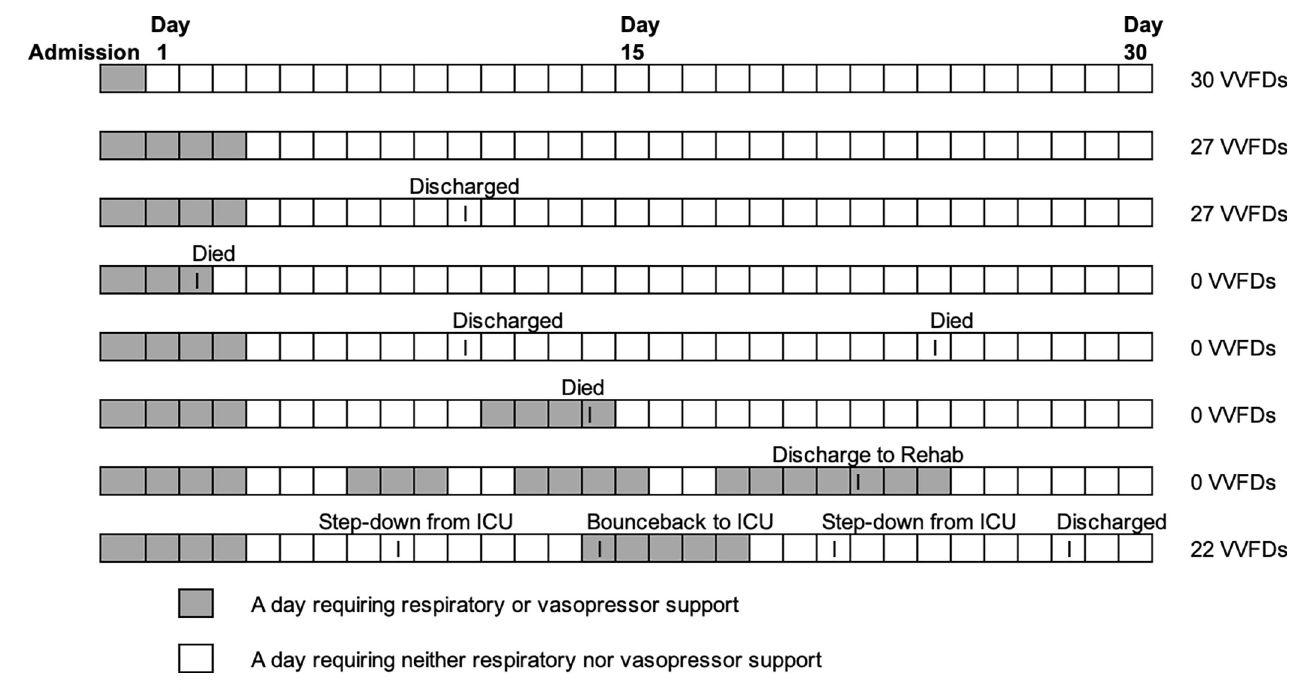
Fig 3. Examples of VVFD scenarios to determine clinical